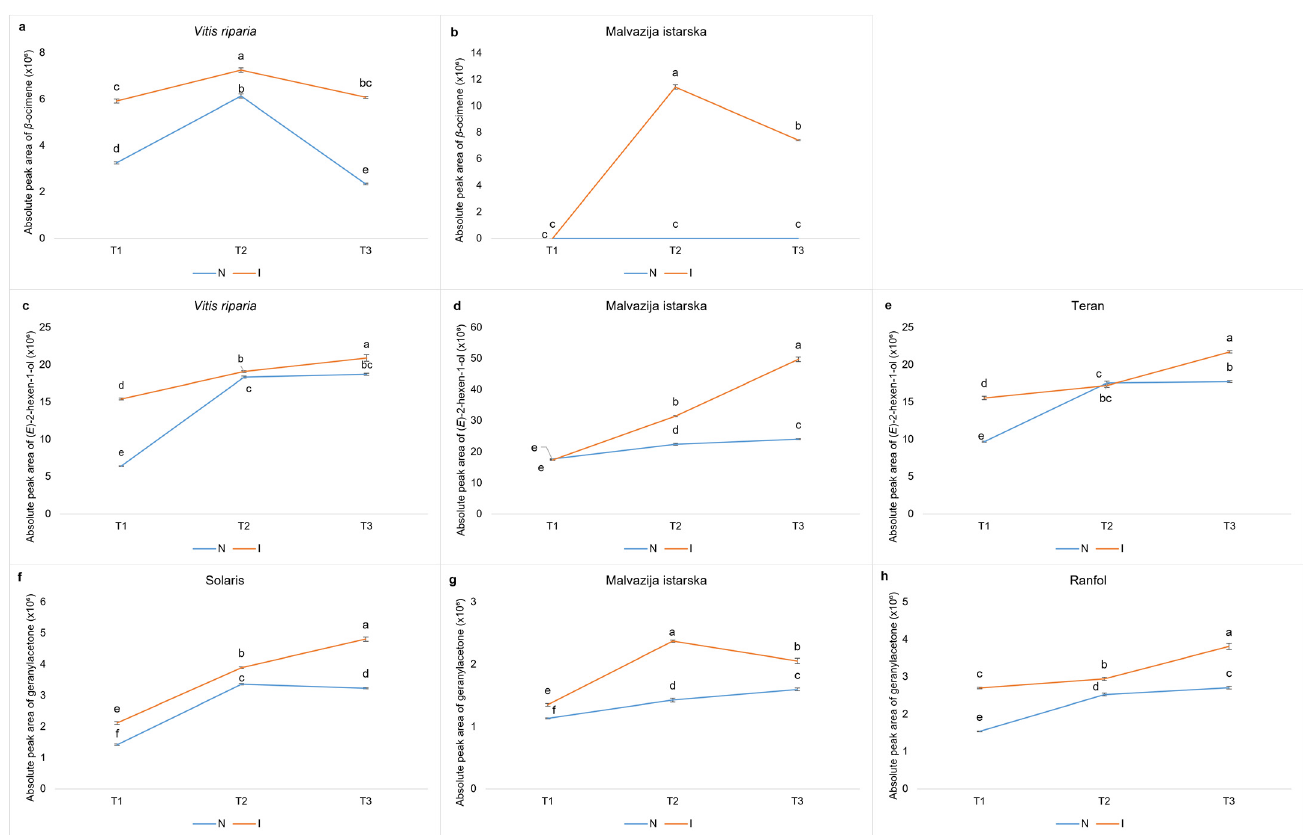
Figure 1. The absolute peak areas of β -ocimene, ( E )-2-hexen-1-ol, and geranylacetone in the sampling terms upon P. viticola inoculation (24 hpi (T1), 48 hpi (T2) and 96 hpi (T3)) for inoculated (I) and non-inoculated (N) samples of genotypes that belong to resistance classes 5 (Malvazija istrska, Ranfol, and Teran), 7 (Solaris), or 9 ( Vitis riparia ). The differences between the means were evaluated by Duncan’s multiple range test at a confidence level of 95% ( p < 0.05). Different letters indicate statistical significance. Sub-figures depict the absolute peak areas of volatile organic compounds as follows: ( a ) β -ocimene in Vitis riparia, ( b ) β -ocimene in Malvazija istarska, ( c ) ( E )-2-hexen-1-ol in Vitis riparia , ( d ) ( E )-2-hexen-1-ol in Malvazija istarska, ( e ) ( E )-2-hexen-1-ol in Teran, ( f ) geranylacetone in Solaris, ( g ) geranylacetone in Malvazija istarska, and ( h ) geranylacetone in Ranfol.